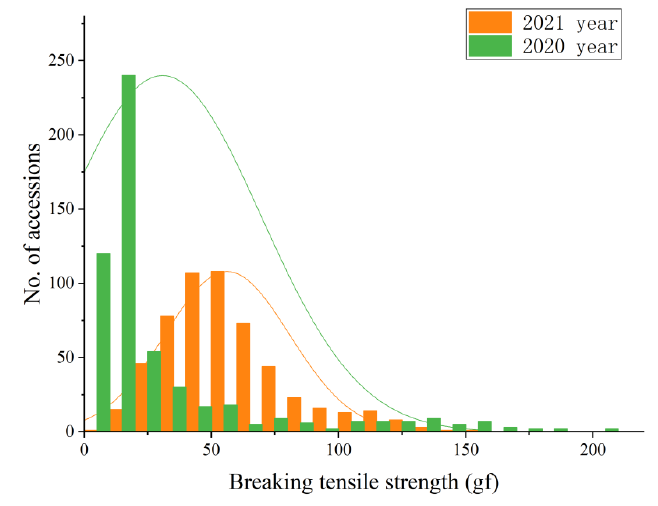
Figure 1. Phenotypic diversity of 587 rice varieties.